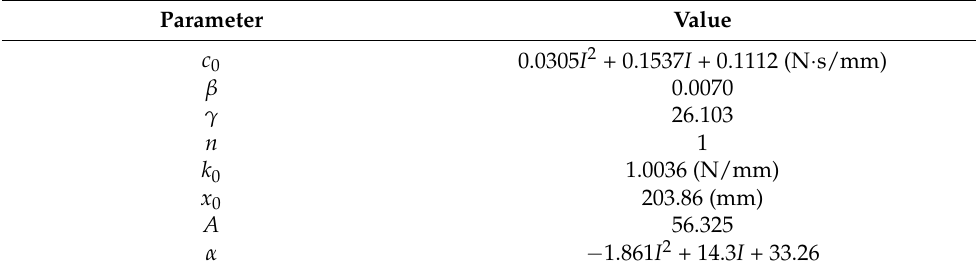
Table 1. Bouc-Wen model parameters.